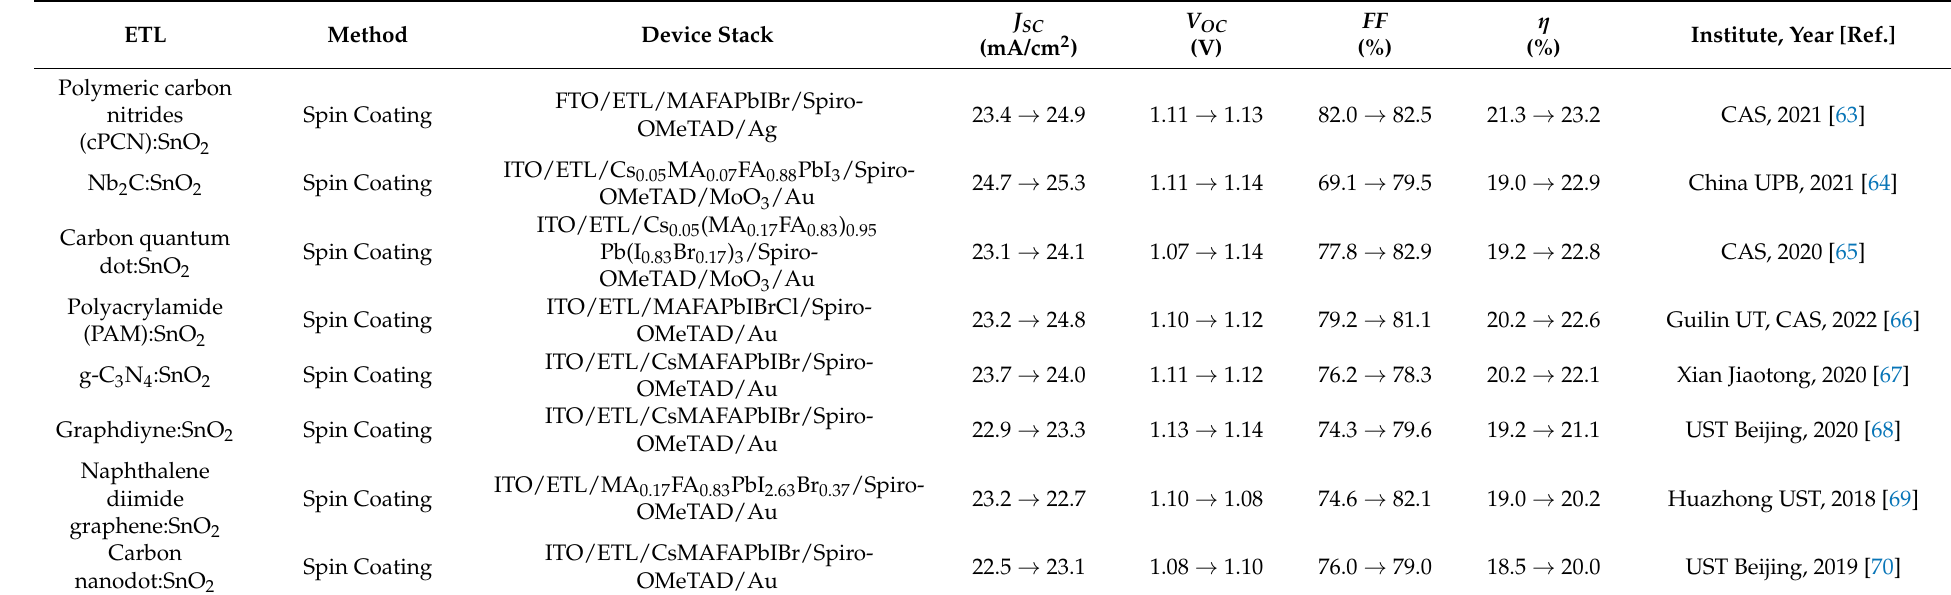
Table 6. Summary of perovskite-solar cells based on bulk incorporation of carbon materials into SnO 2